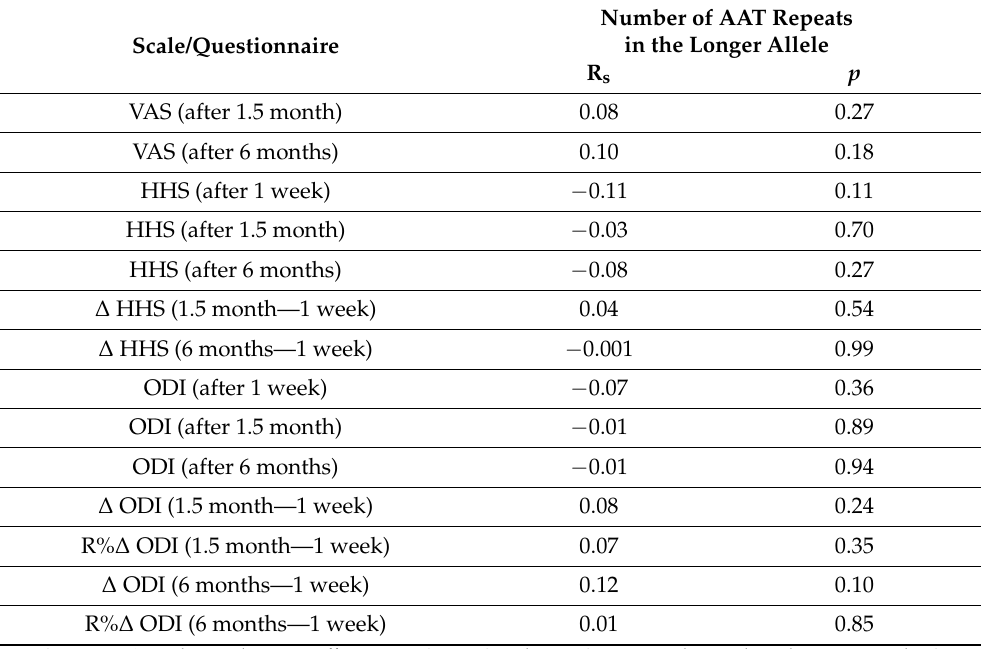
Table 10. The correlations between the number of AAT CNR1 repeats in the longer allele, pain intensity, hip function, and the degree of disability in patients at defined intervals.